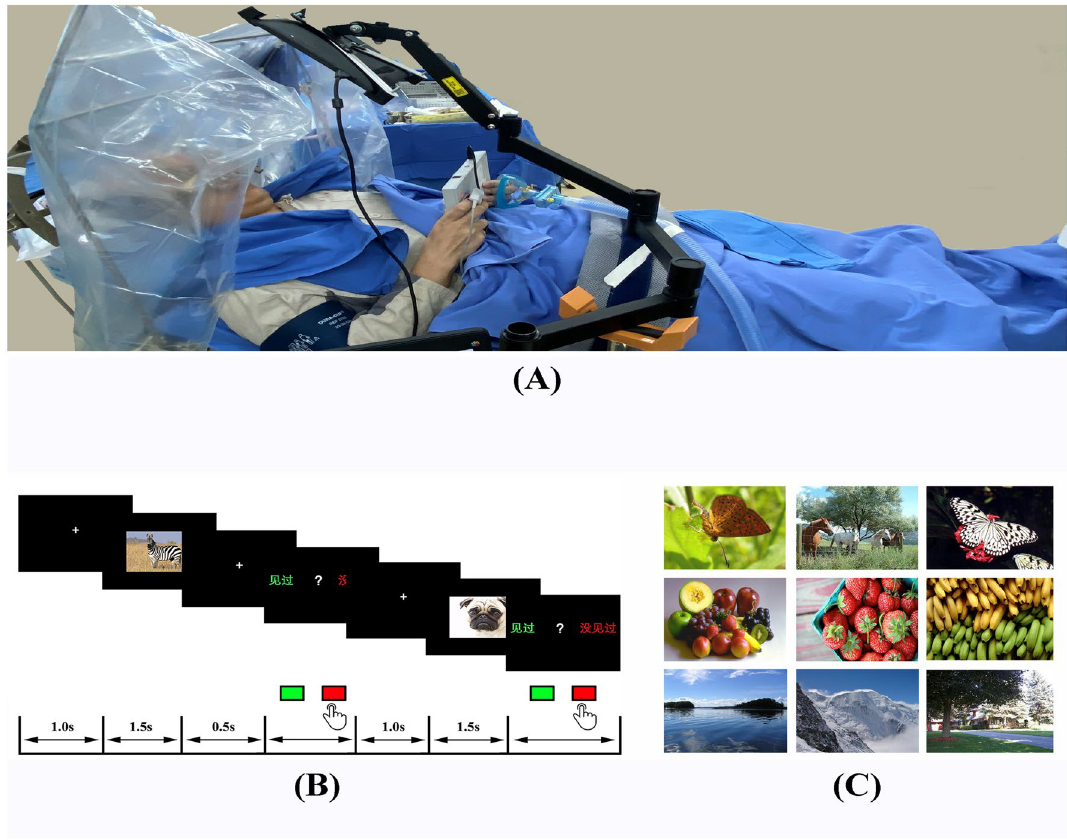
Figure 1. The memory test used in the study. ( A ) Devices, patient position and settings during the memory test. ( B ) Upper panel, screens presented to the patients during an example trial. Lower panel, the lengths of time for which each screen was shown. ( C ) Sample images used in the